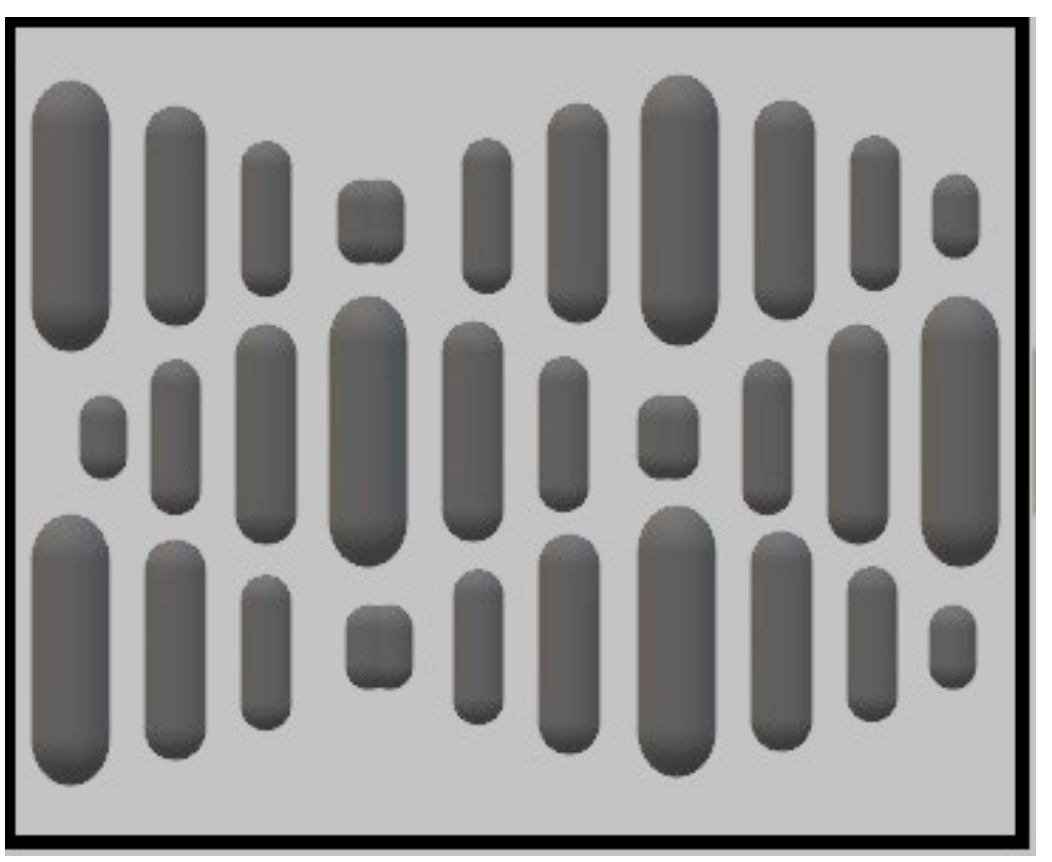
Figure 3. Schematics of the Sharklet pattern.